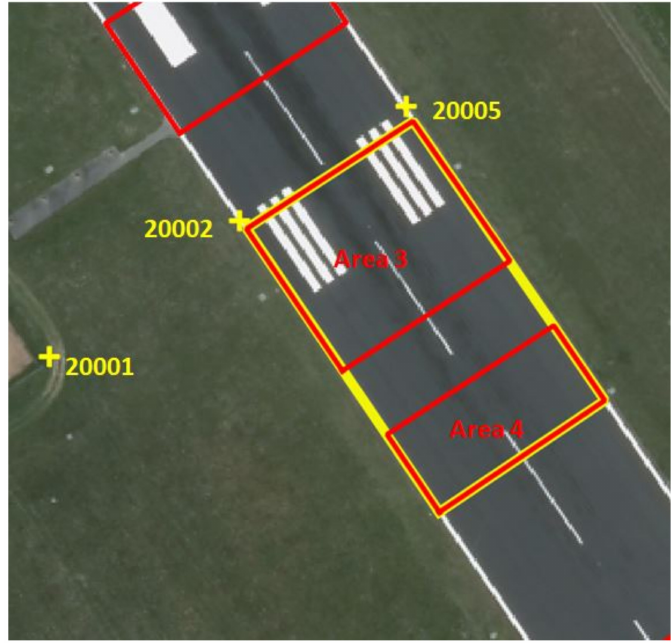
Figure 12. Comparison